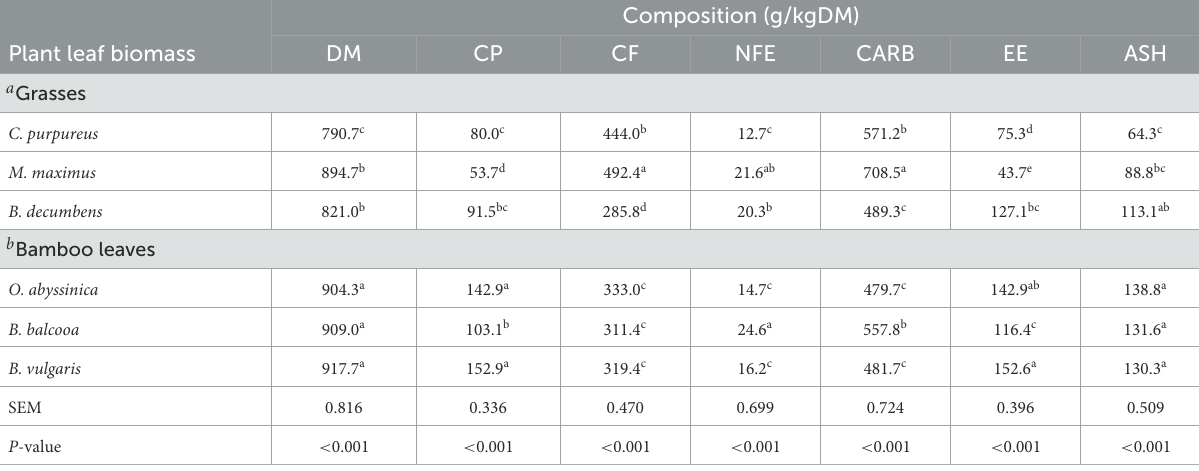
TABLE 1 Analytical proximate compositions of bamboo leaves and grass samples.